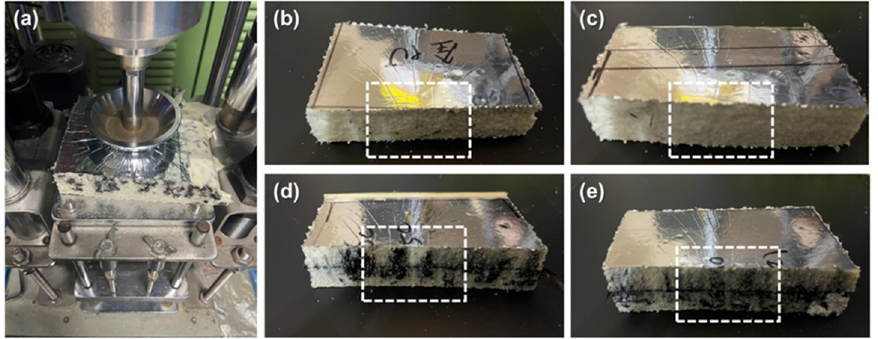
Figure 4. ( a ) Falling weight impact tester, and the corresponding fractured samples of ( b ) PU, ( c ) PU/C, ( d ) PU/C/80 g, and ( e ) PU/C/120 g.